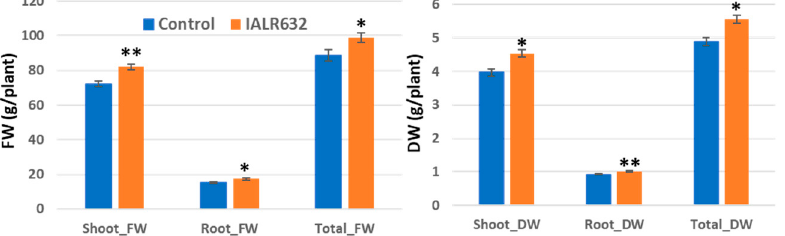
Figure 5. Effects of IALR632 inoculation on plant growth in indoor vertical NFTs (31 March 2002 to 22 April 2022). *, ** on the column mean statistically significant difference at p < 0.05 and 0.01, re-